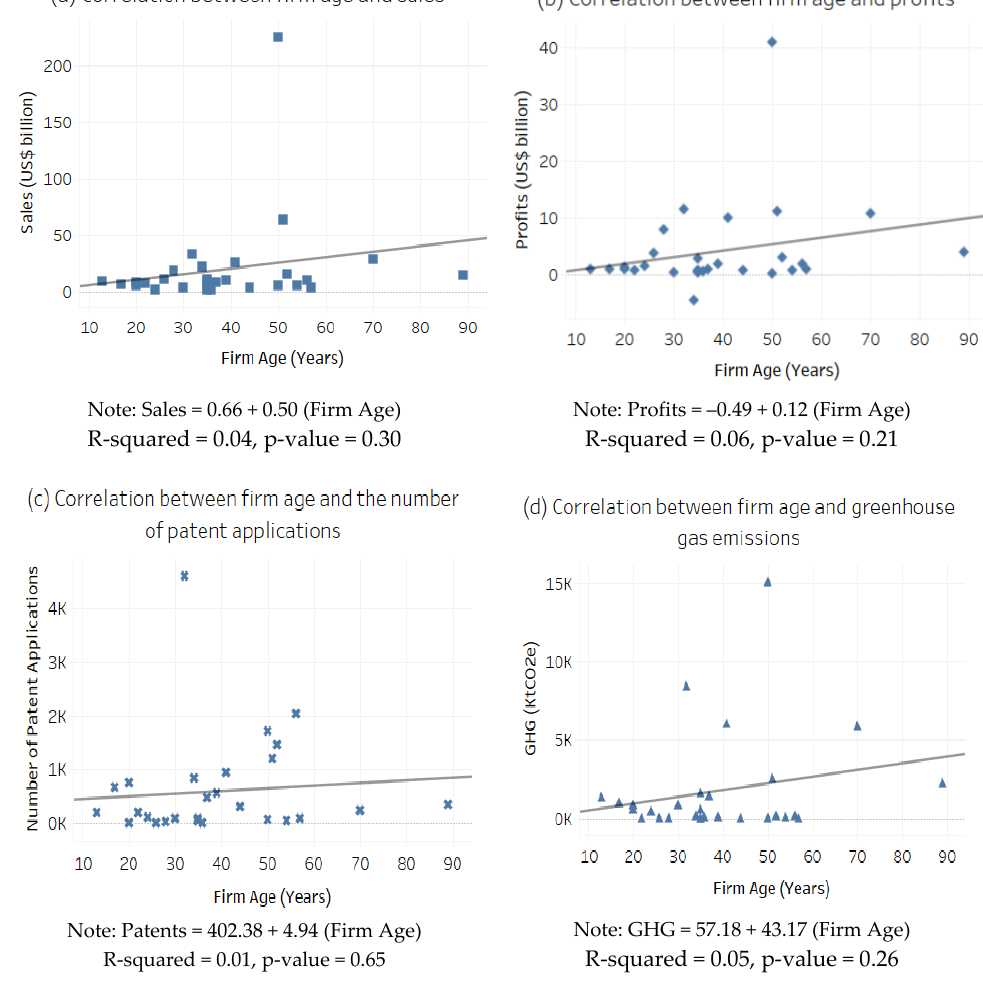
Figure 2. Correlations between firm age and outputs: ( a ) sales; ( b ) profits; ( c ) patents and ( d ) GHG.